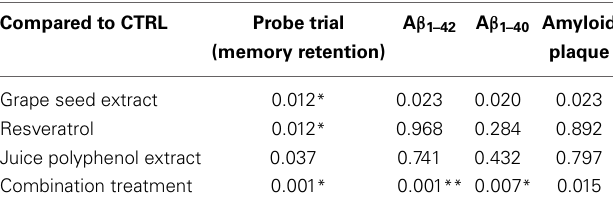
FIGURE 2 | Chronic Comb treatment attenuates cognitive deterioration in J20 mice. (A–D) The influence of chronic GSE, Resv, Juice, or Comb treatment on A β -related spatial memory in J20 mice vs. untreated control J20 mice in the Morris water maze test. Hidden platform acquisition: latency score represents the time taken to escape to the platform from the water (E) Table 2 | Significance of comparisons of the control treatment with GSE, Resv, Juice, or Comb